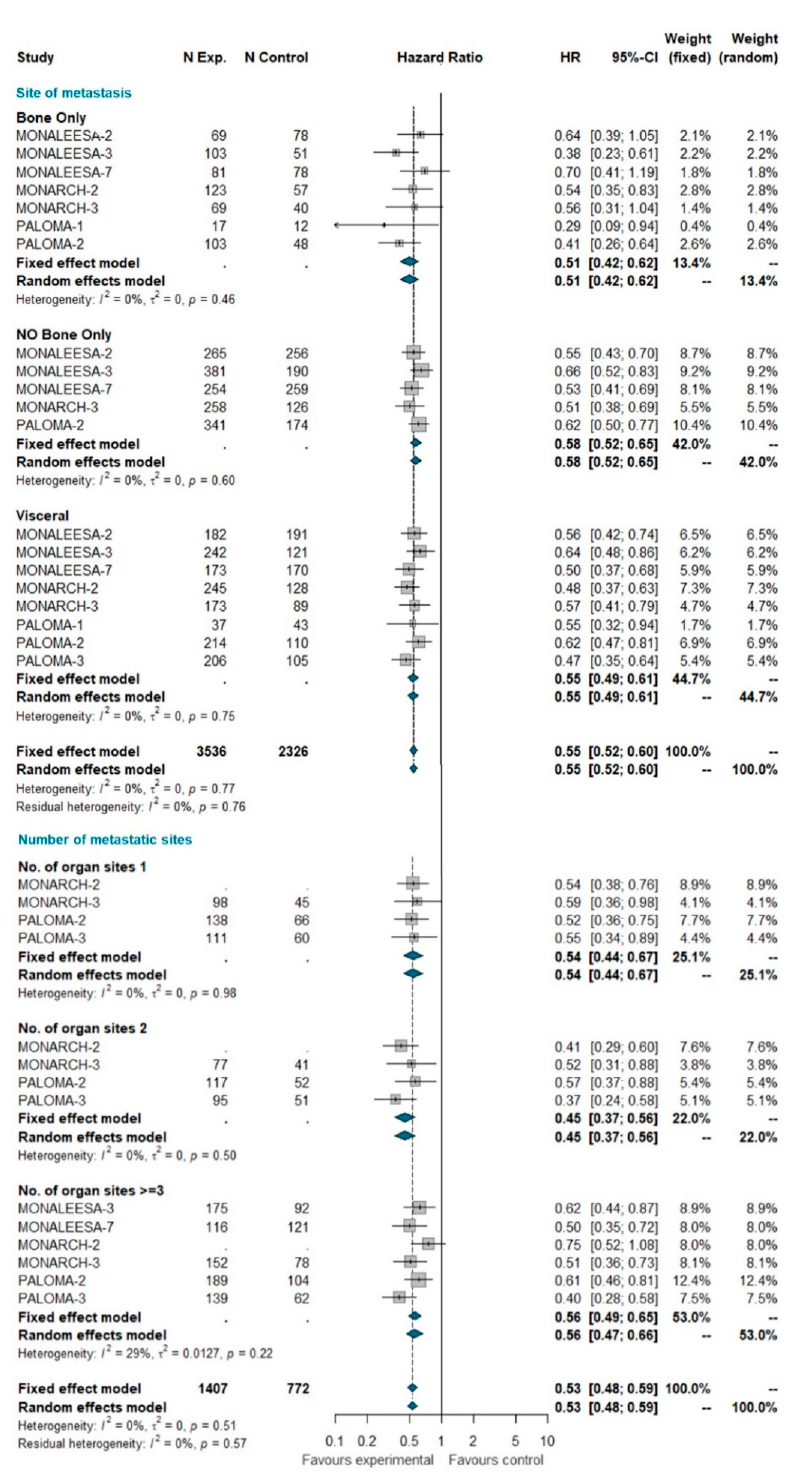
Figure 2. Pooled comparison of PFS according to site of metastasis (visceral disease, bone-only disease and no bone-only disease) and number of organs involved (1, 2, 3+). Abbreviations: PFS: progression free survival; N exp: number of patients randomized in experimental arm; N control: number of patients randomized in control arm; HR: hazard ratio; CI: confidence